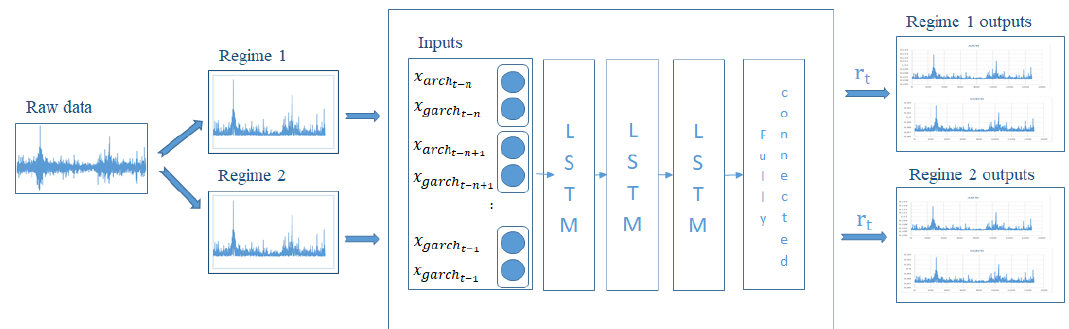
Figure 1 . Block diagram of the proposed GARCHLSTM method.